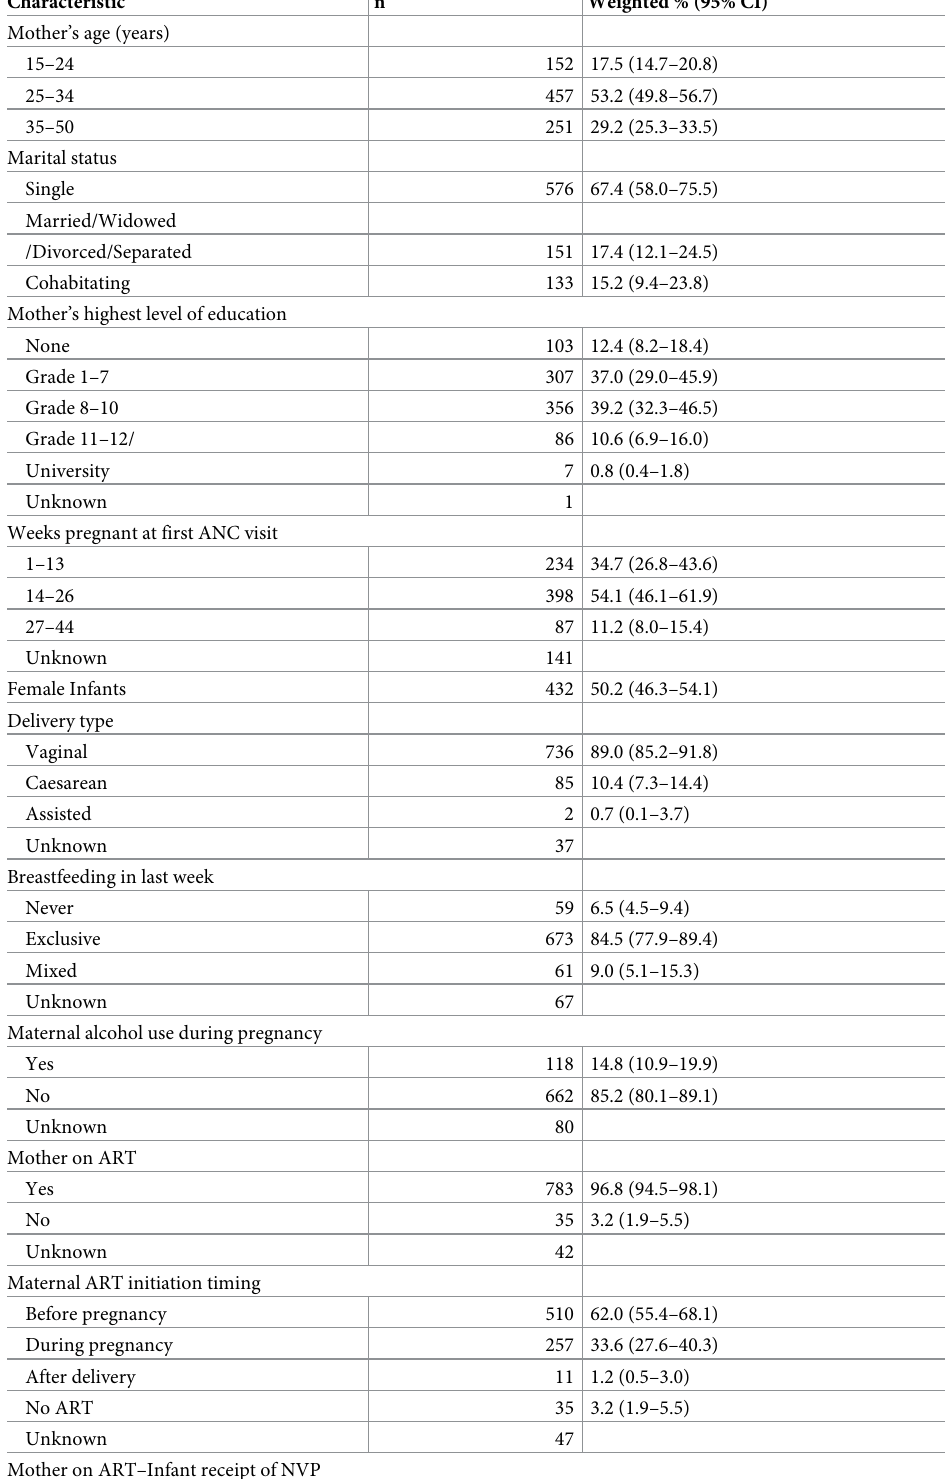
Table 1. Characteristics of the study population of 860 mother-infant pairs, Namibia, 2014 −